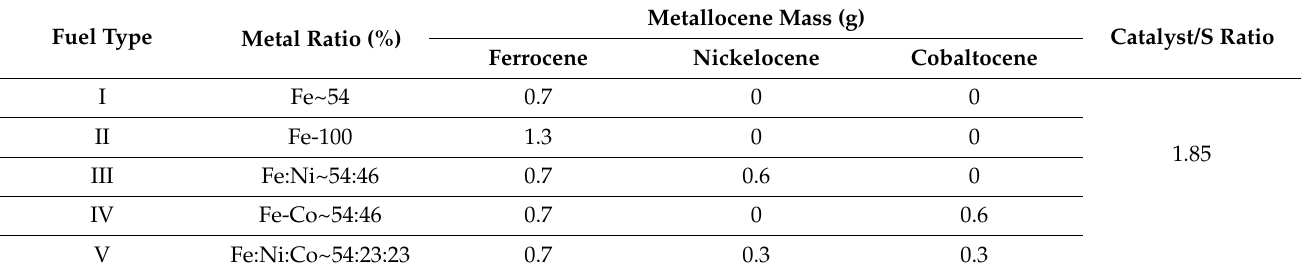
Table 1. Metallocene mass dissolved in 100 mL of the fuel.